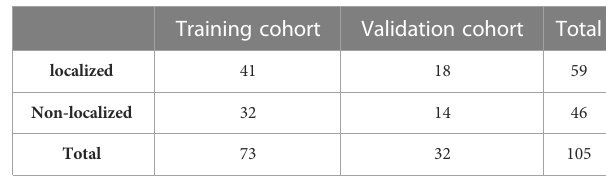
Table 1. The fl ow diagram of this radiomics study consists of lesion TABLE 1 Details of our dataset in this